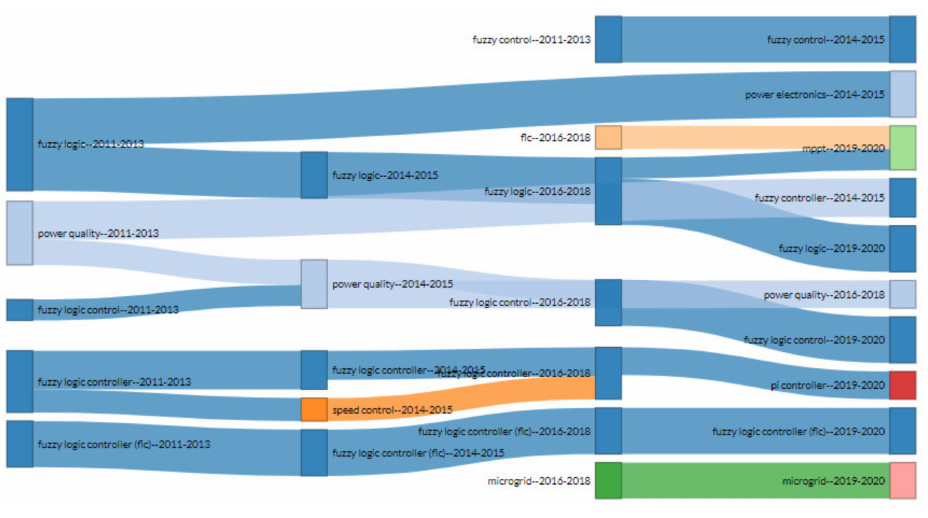
Figure 22. Thematic